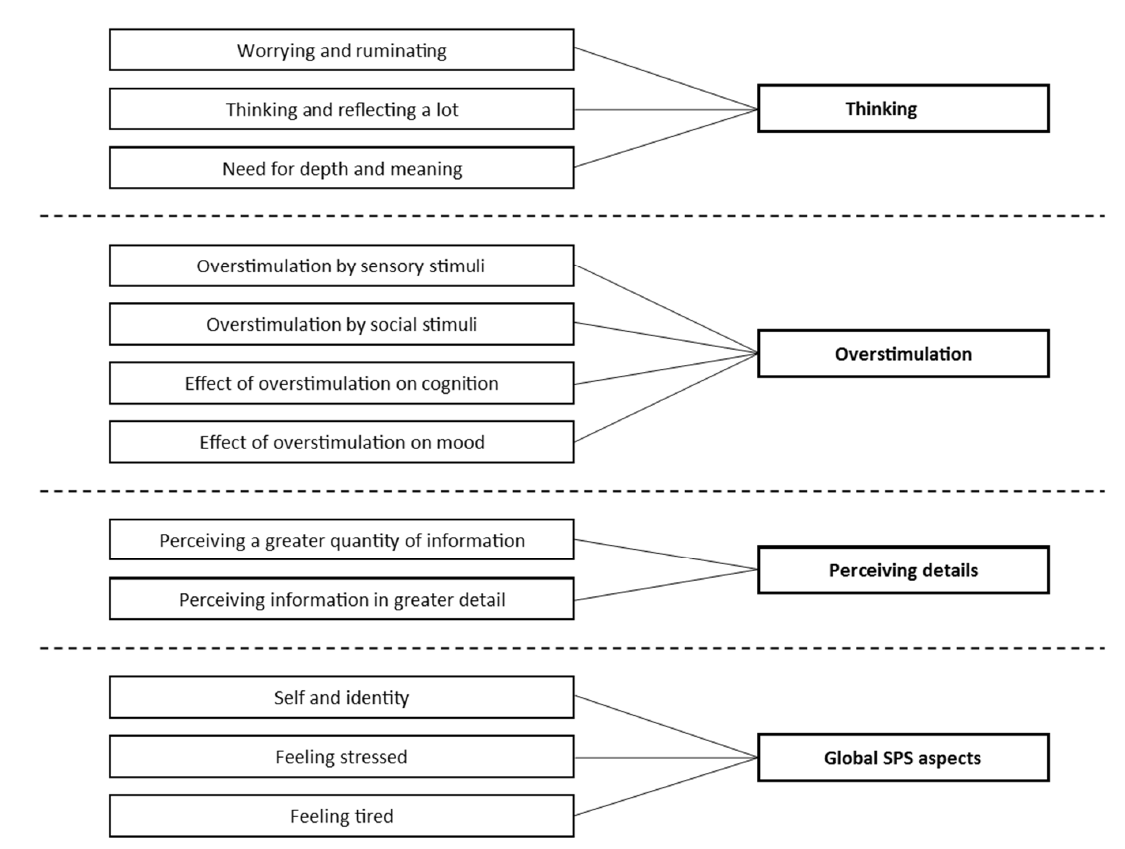
Figure 2. Identified themes and subthemes in SPS